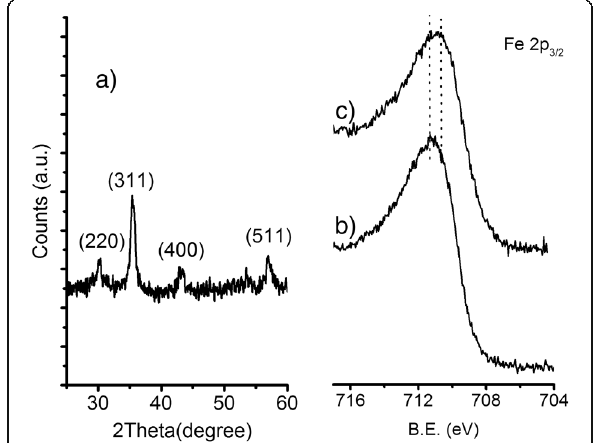
Fig. 2 Typical XRD and XPS spectra of MNPs. XRD pattern of a) bare MNPs and high-resolution Fe 2p 3/2 XPS spectral regions of b) bare MNPs and c) NH 2